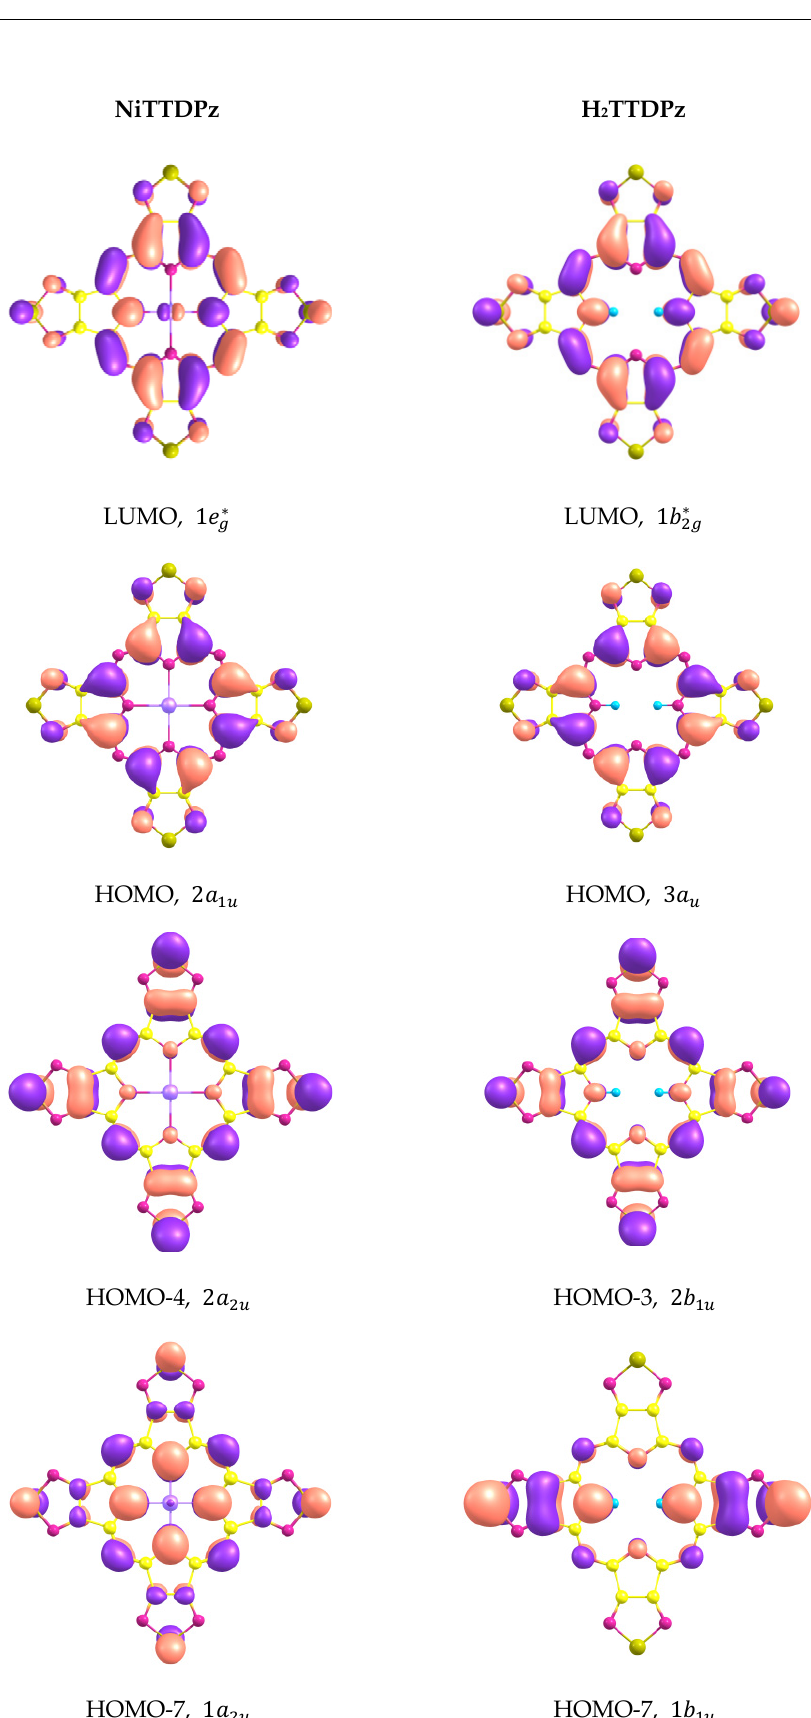
Figure 7. Shapes of molecular orbitals that participate in electronic transitions with large oscillator strengths.